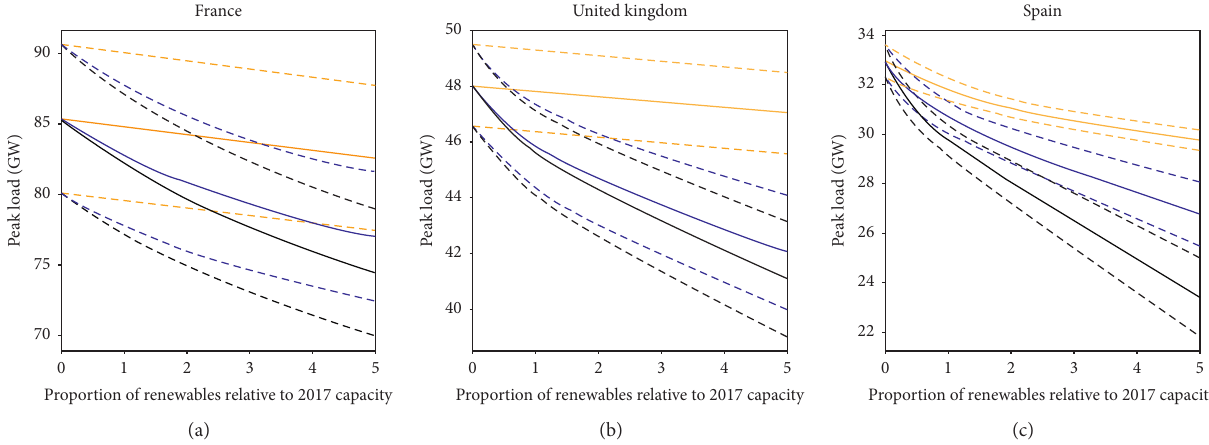
Figure 5: Mean peak load for various fractions of installed renewable generation, for 1979–2018, for (a) France, (b) the United Kingdom, and (c) Spain. Solid lines show the 1979–2018 mean peak load, whereas dotted lines show 2 standard deviations from the mean peak load. Line colours show demand-net-solar (yellow), demand-net-wind (blue), and demand-net-wind-and-solar (black).